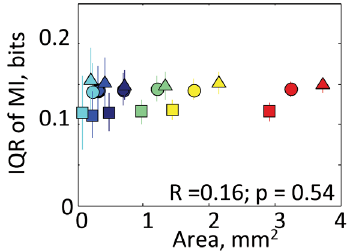
Figure 4. Validation that the positive correlation between the representational area and MI variance is caused by frequency- dependent MI distribution, but not by inadequate sampling. IQR was estimated as a function of the representational area in shuffled data, which were randomly resampled irrespective of any properties. The shapes of symbols indicate the test training groups: circle, naı¨ve; triangle, day 4; and square, day 20. Representational areas of each resampled dataset were determined on the basis of the tonotopic map in each training group. Means and standard deviations are shown when the resampling was conducted 100 times. No significant correlation between IQR and representational area was observed, thereby denying the possibility that IQR may increase with the number of samples because test datasets are inadequately small.